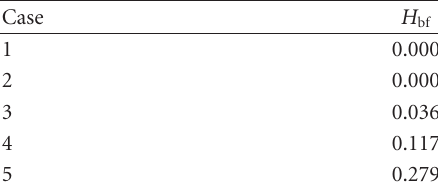
Table 10: H bf obtained for each case.